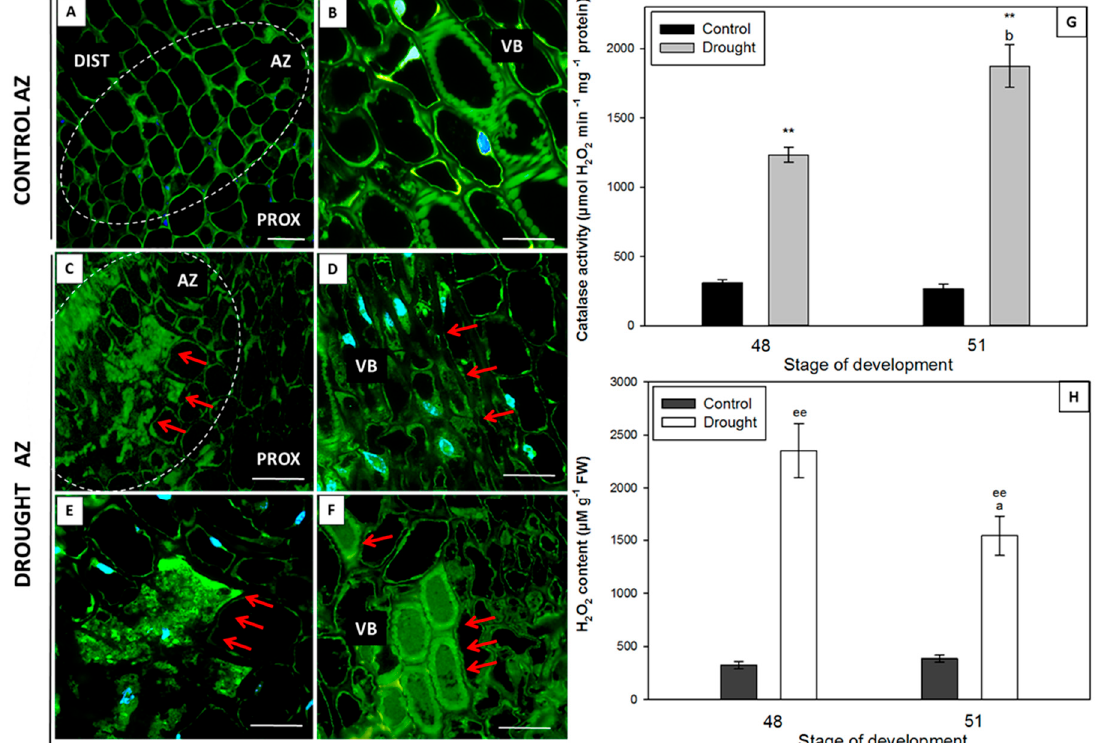
Figure 5. Immunolocalization of catalase (CAT) in the floral abscission zone (AZ) of yellow lupine grown in drought conditions ( C – F ) and in the AZ of control plants ( A , B ). The AZs were excised on the 48th day of development. Control plants were cultivated under optimal soil conditions (70% WHC). Stressed plants were subjected to drought for 2 weeks (25% WHC). The AZ region is indicated by white curves ( A , C ). The presence of CAT is highlighted by red arrows. Image E is magnified C . Nearby cells to vascular bundles ( D ). Magnified vascular bundles ( B , F ). Nuclei were stained with